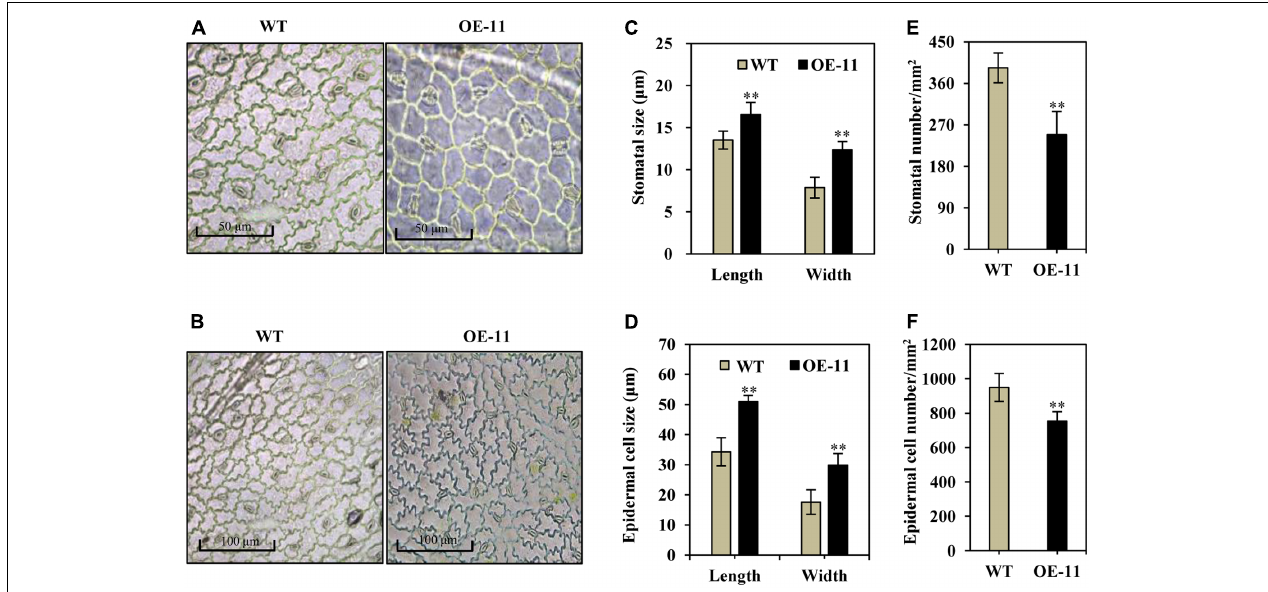
FIGURE 4 | Enlarged stomata size, reduced stomatal and epidermal cell density in AtEDT1 transgenic alfalfa plants. (A,B) Comparison of adaxial epidermal imprint images of wild type (left) and transgenic line OE-11 (right). A surface imprint was used as described in the Experimental Procedures. Bar = 50 µ m (A) . Bar = 100 µ m (B) . (C) Stomata size of wild type and transgenic line OE-11. One leaf from similar position of wild type and transgenic line OE-11 was respectively sampled for surface imprint. Values are means ± SD of 13 stomata ( ∗∗ P < 0.01). (D) Stomatal cell density of wild type and transgenic line OE-11. Values are means ± SD of five images ( ∗∗ P < 0.01). (E) Epidermal cell size of wild type and transgenic line OE-11. Values are means ± SD of 10 cells ( ∗∗ P < 0.01). (F) Epidermal cell density of wild type and transgenic line OE-11. Values are means ± SD of four images ( ∗∗ P <